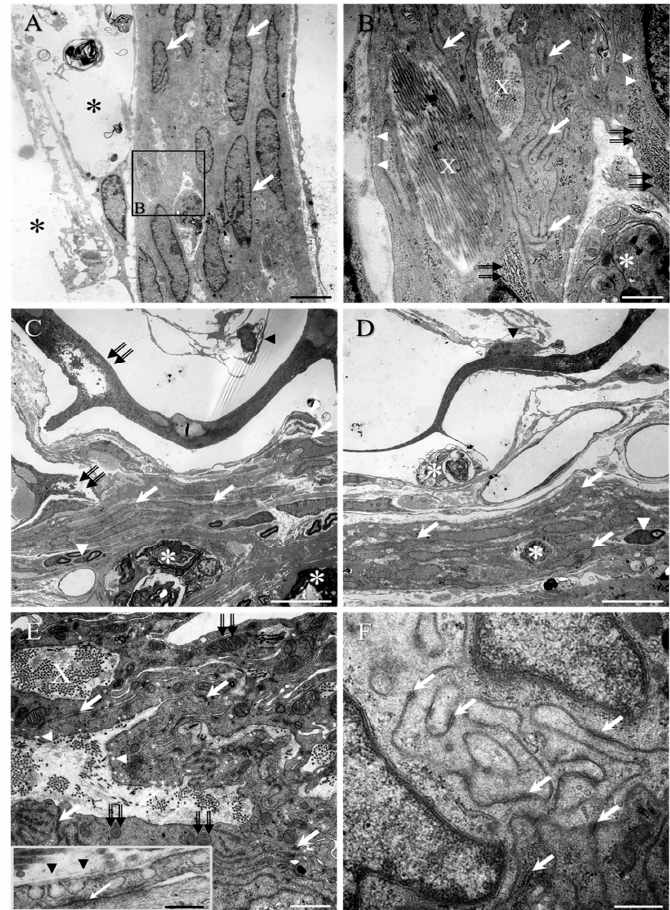
Figure 6. Ultrastructure of PNLC at the medial surface of the dura mater from the lesion-only control group ( A , B ) and at the transition zone from the collagen scaffold-implanted group ( C – F ). ( A ) Multiple overlapping reactive PNLC forming the tissue bridge at the medial (or inner) edge of the repaired dura mater of lesion-only control animals. Cystic cavitation is indicated by asterisks. The similar directionality of the ovoid-shaped nuclei (white arrows) suggests that the cells had all adopted the same orientation. ( B ) Higher magnification of boxed area in ( A ). Bundles of collagen fibrils (X; see also within the transition zone of ( E )) appear trapped within lacunae located between the cells, as do phagocytic macrophages (asterisk). Large numbers of electron-dense, tight junctions (white arrows; see also ( E , F ) for transition zone) are formed between the fine overlapping cell processes, and many pinocytotic vesicles can be seen close to the plasma membrane (white arrowheads; see also ( E ) for the transition zone). An abundance of rER (double black arrows) is also present within the cell body. ( C , D ) The same PNCL-like features, with predominantly ovoid-shaped nuclei, were observed in the transition zone around the implanted scaffolds (white arrows). The collagen framework of the scaffolds showed signs of degradation (e.g., double black arrows in ( C )), with fibroblast-like cells and their long, fine processes being located within the lumen of the porous framework or adherent to the collagenous walls (black arrowheads in ( C , D ), respectively). Small groups of Schwann cell- myelinated axons (white arrowheads in ( C , D ), respectively) and phagocytic macrophages (asterisks in ( C , D )) were also embedded amongst the overlapping cells and processes. ( E , F ) Pockets or lacunae of dense and loosely packed collagen fibrils (X) were trapped between the cell processes, which were connected by multiple electron-dense, tight junctions (white arrows in ( E ) and insert in ( F )). Numerous pinocytotic vesicles (white arrowheads in ( E ); see also insert) and mitochondria (double arrows in ( E )) suggested high levels of transport and metabolic activity. A discontinuous basal lamina was also regularly observed (e.g., black arrowheads, insert in ( E )). Scale bars: A = 5 µ m; B = 1 µ m; C , D = 10 µ m; E = 1 µ m (insert, 200 nm); F = 500